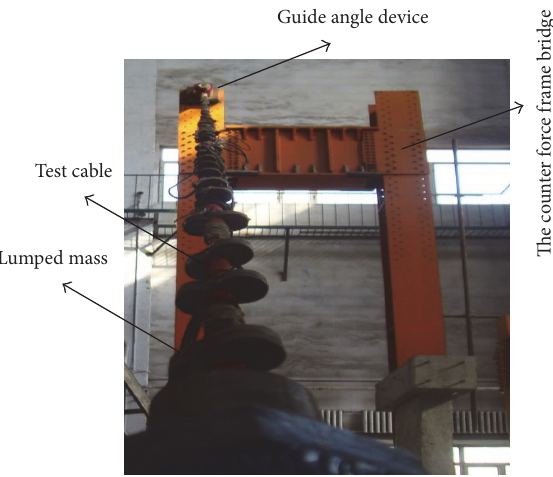
corresponding connecting pieces between components. So